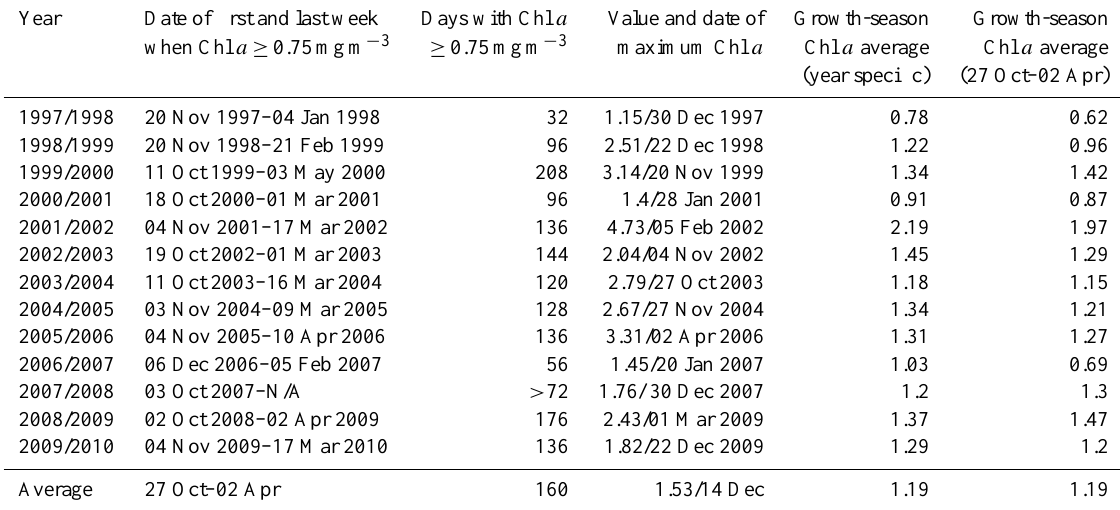
Table 1. Column 2 and 3: phytoplankton bloom duration; Column 4: growth-season’s maximum Chl a value and its timing (date of week); Column 5: year’s specific seasonal Chl a average (based on the growth-season durations indicated in Column 2); Column 6: Chl a seasonal average based on the average growth-season length (i.e., from 27 October to 02 April). All concentrations values are expressed inmgm − 3